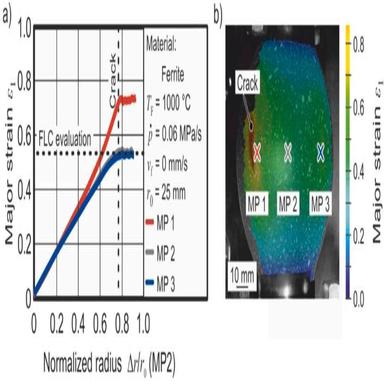
Definition of the evaluation points for the FLC from the hot-tube-bulge test. a) Major strain ε1 over normalized radius Δr/r at three different measurement points (MP) and b) used DIC measurement as well as the location of the three measurement points in the first image after failure.